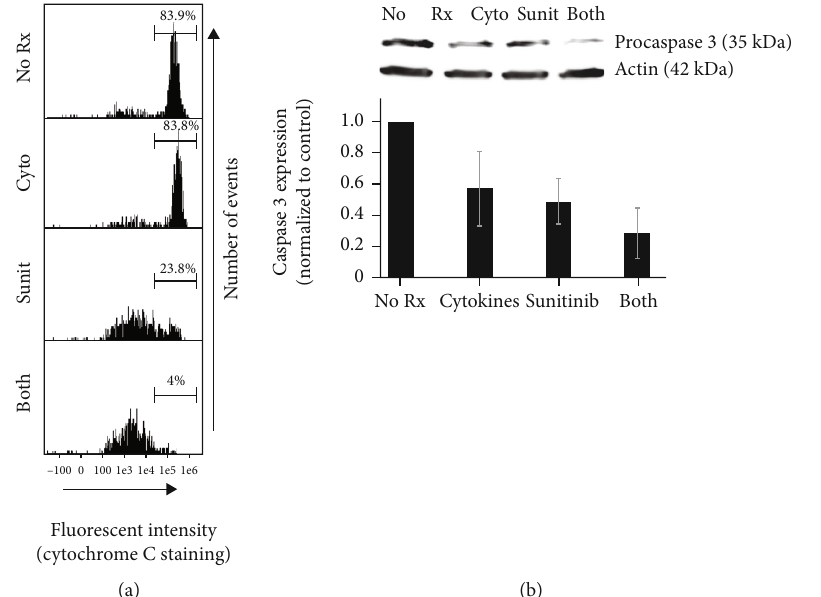
Figure 4: Sunitinib and Th1 cytokine treatment maximizes cytochrome C release from mitochondria and degradation of PARP. SKBR-3 cells were seeded at 5 × 10 4 per mL and were left untreated (No Rx) or treated with Th1 cytokines (5 ng/mL each), sunitinib (10 μ M), or sunitinib and Th1 cytokines (both) for 72 hours. (a) Cells were harvested, permeabilized, and stained fi rst with anti-cytochrome C antibodies, followed by an APC-labeled secondary antibody. Cells were then analyzed by fl ow cytometry using a 642nm excitation laser. Histograms display a single representative experiment of cytochrome C expression in SKBR-3 cell lines out of four total experiments with similar results. (b) Treated cells were harvested and extracted in RIPA bu ff er in the presence of protease and phosphatase inhibitors. Protein lysate (30 μ g/well) was separated on a 4-15% SDS gel and electrotransferred onto nitrocellulose membranes. Blots were then probed with anti- PARP (116kDa) and anti-actin (loading control; 42kDa) and bands visualized using chemiluminescence substrate with the Fuji LAS 3000 detection system. Illustrated blot representative of 3 separate experiments with similar